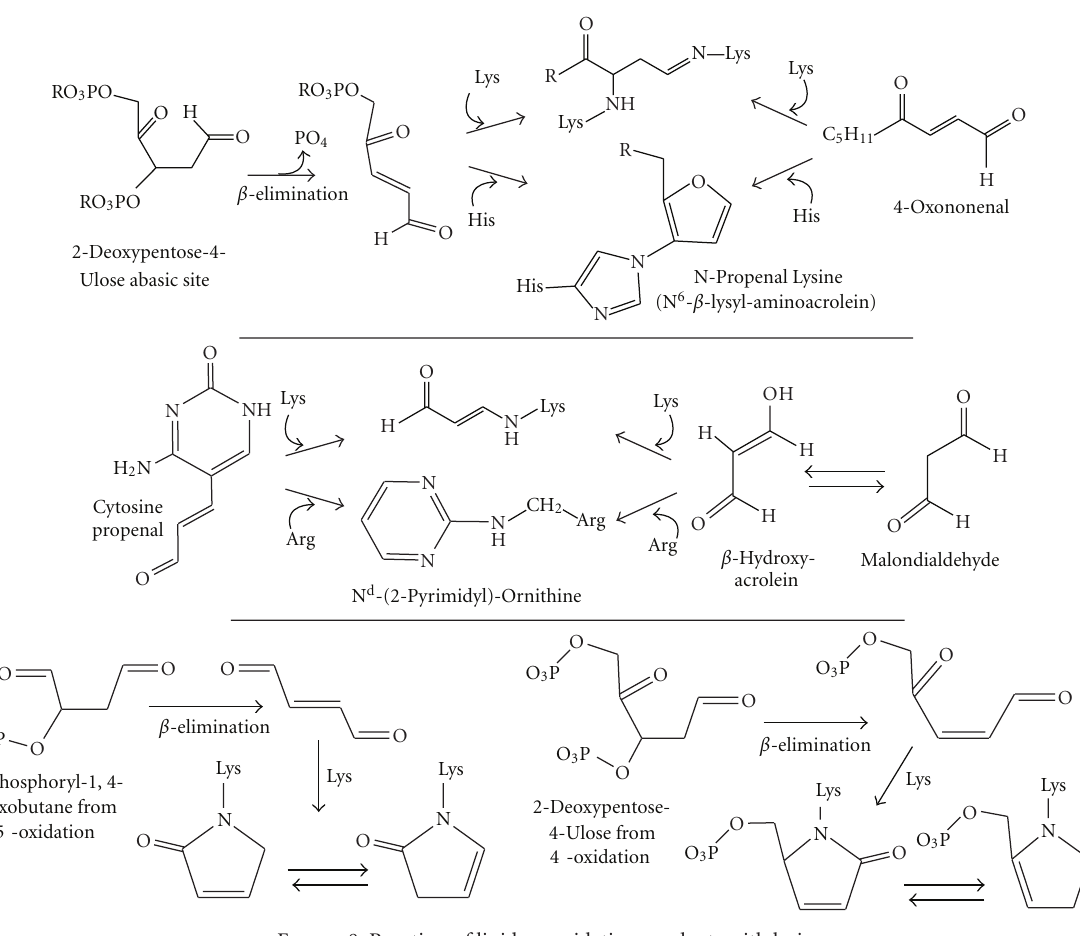
Figure 8: Reaction of lipid peroxidation products with lysine.